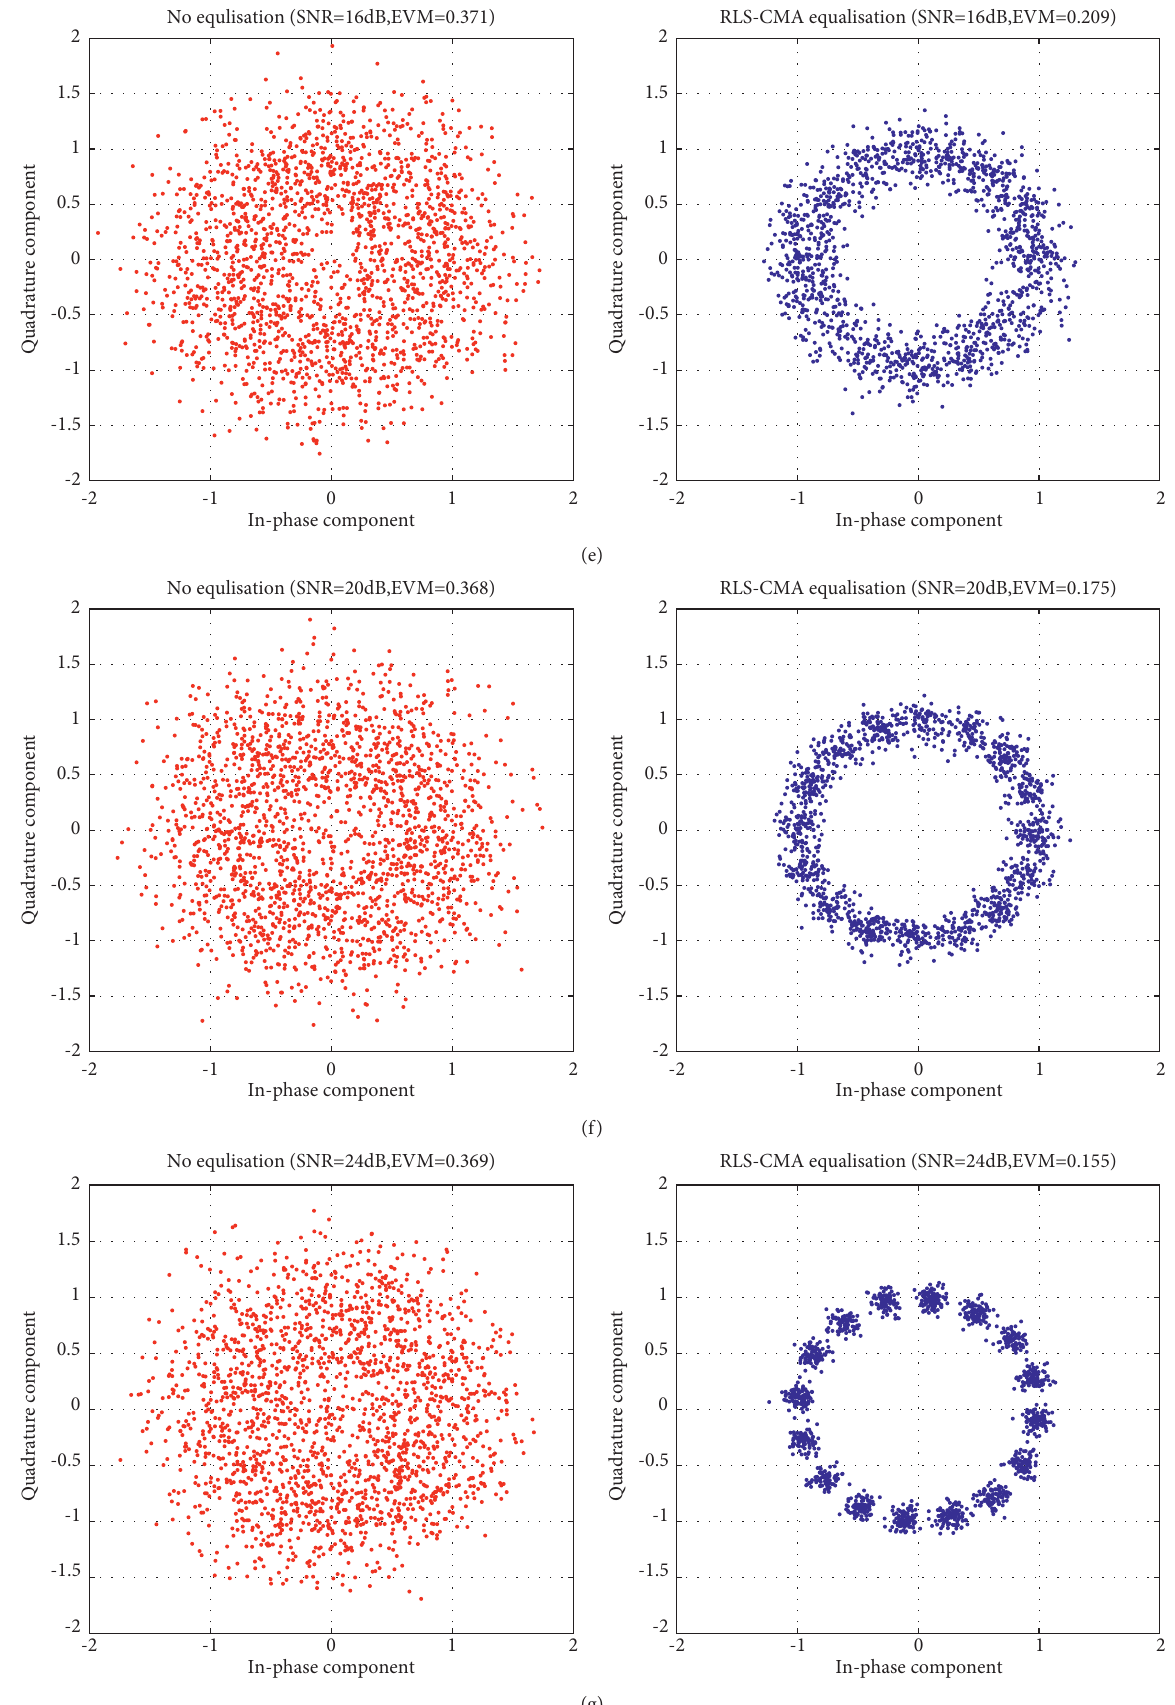
Figure 17: RLS-CMA equalisation of the PSK-modulated signals. (a) 16PSK SNR � 0dB. (b) 16PSK SNR � 4dB. (c) 16PSK SNR � 8dB. (d) 16PSK SNR � 12dB. (e) 16PSK SNR � 16dB. (g) 16PSK SNR � 24dB. (f) 16PSK SNR � 20